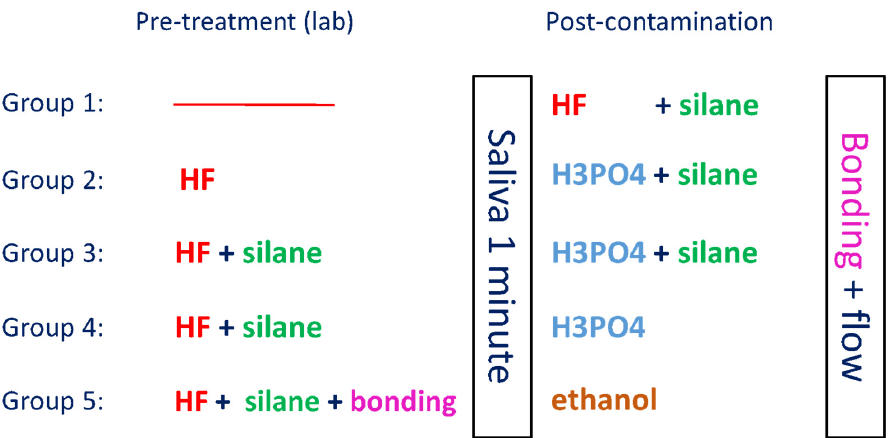
Figure 1. Surface treatment methods of the different groups (hydrofluoric acid (HF); phosphoric acid (H 3 PO 4 )).